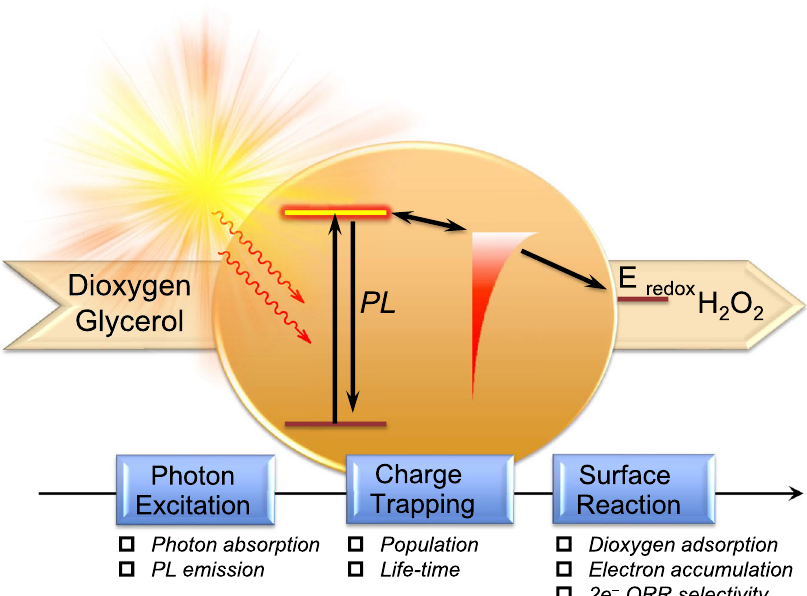
Fig. 1 Illustration of the sequential mechanisms of the photophysical, photochemical, and surface reaction steps involved in solar-driven H 2 O 2 production